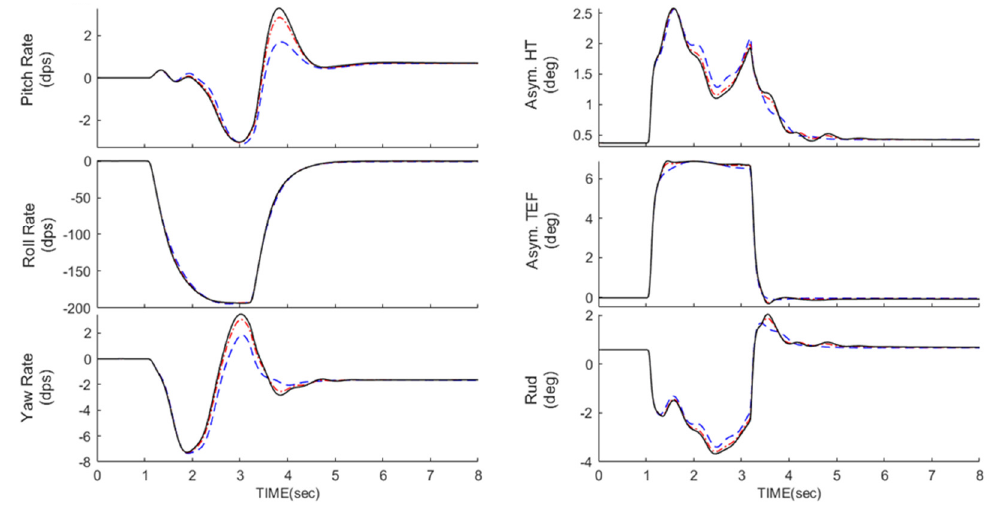
Figure 13. Simulation result of maximum roll rate performance characteristics to max 360 degree roll maneuver in M0.8, 20 Kft altitude.